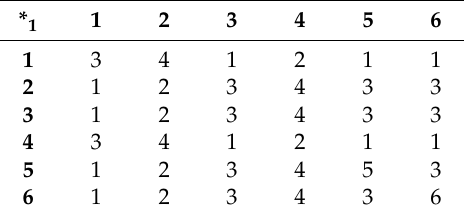
Table 4. The operation * 2 on N 2